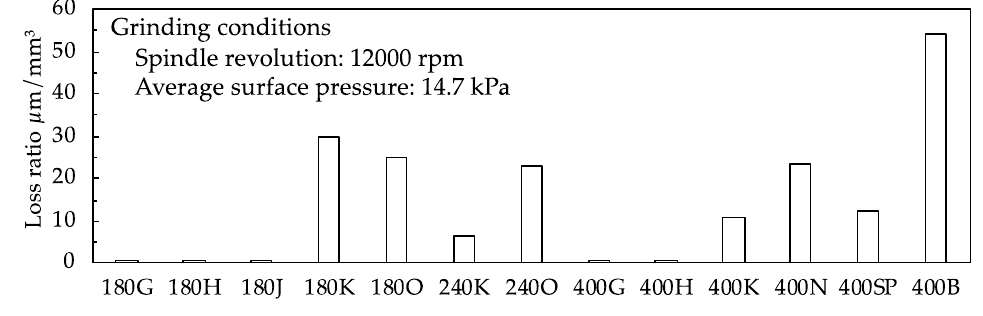
Figure 7. Loss ratio of each wheel.